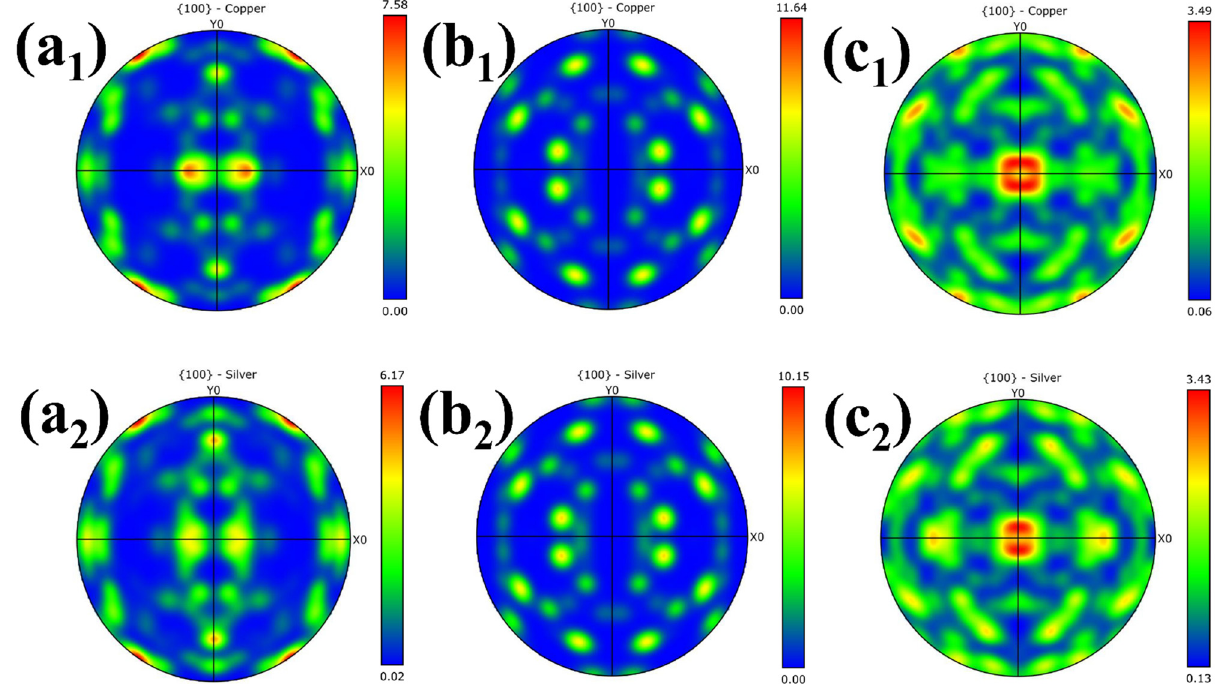
Figure 8: Pole fi gures of Ag ( s.s ) and Cu ( s.s ) in the brazing seam. ( a 1 ) and ( a 2 ) 0%; ( b 1 ) and ( b 2 ) 2%; ( c 1 ) and ( c 2 ) 3%.